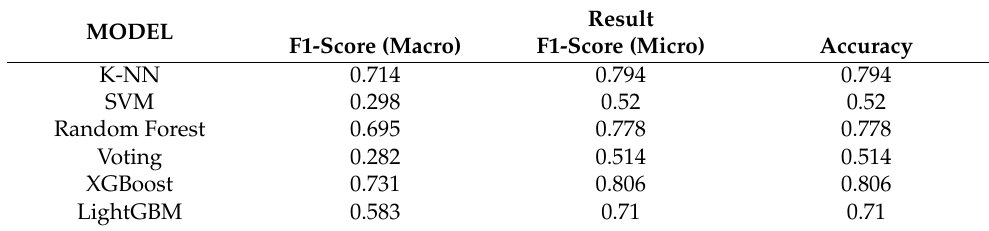
Table 5. Tourist activity pattern classification results according to real-time